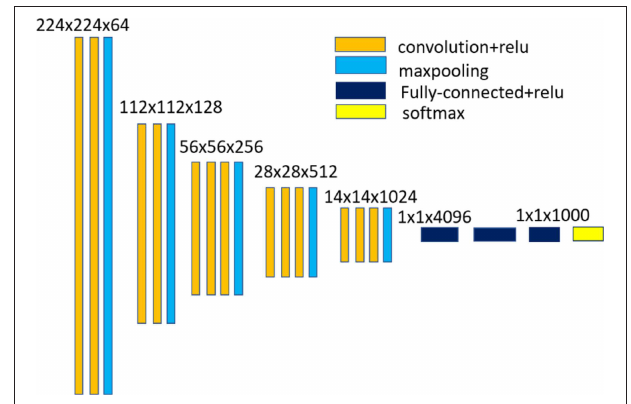
FIGURE 2 | Network architecture of the